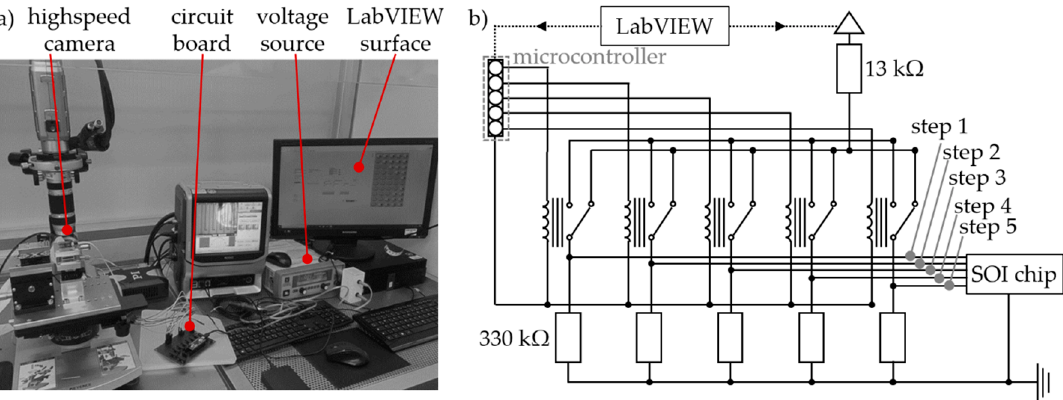
Figure 8. ( a ) Characterization setup in the cleanroom, ( b ) setup of the printed circuit board.